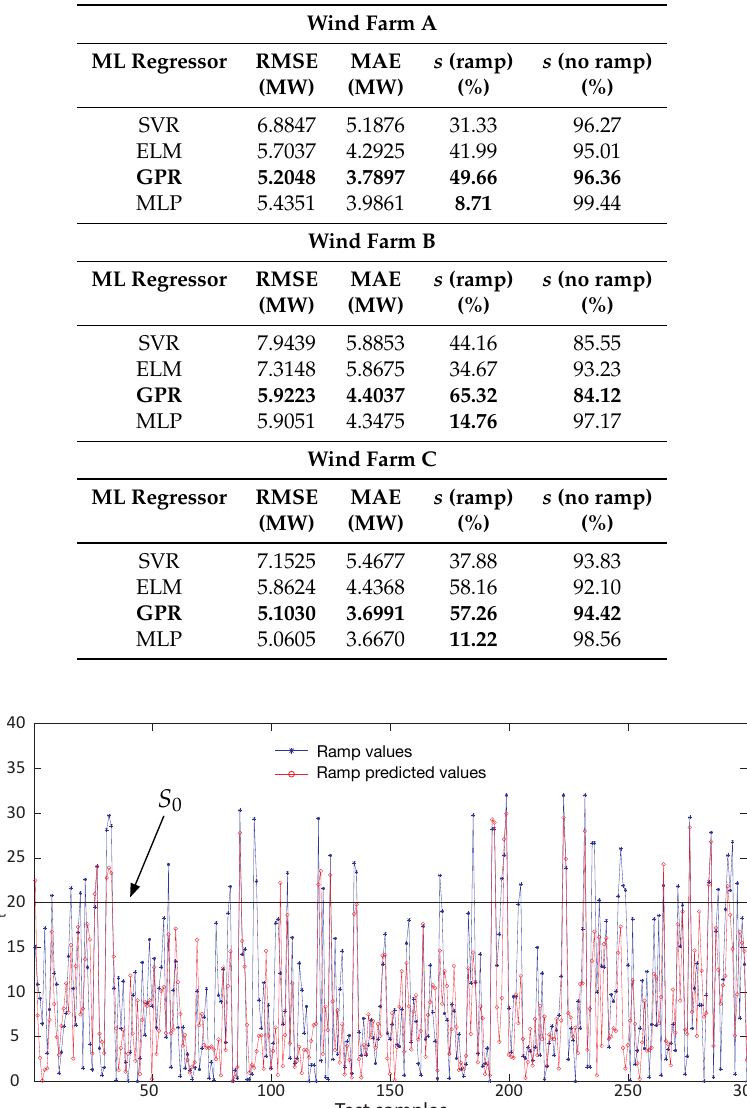
Figure 5. Estimation of the ramp function S 2 t ( Equation (2) ) obtained by the proposed approach using the GPR regressor, in Wind Farm A. The ramp predicted values resemble the ramp measured ones with RMSE ≈ 5.20 MW and MAE ≈ 3.79 MW, s (ramp) = 49.66% and s (no ramp) = 96.36% (see Table